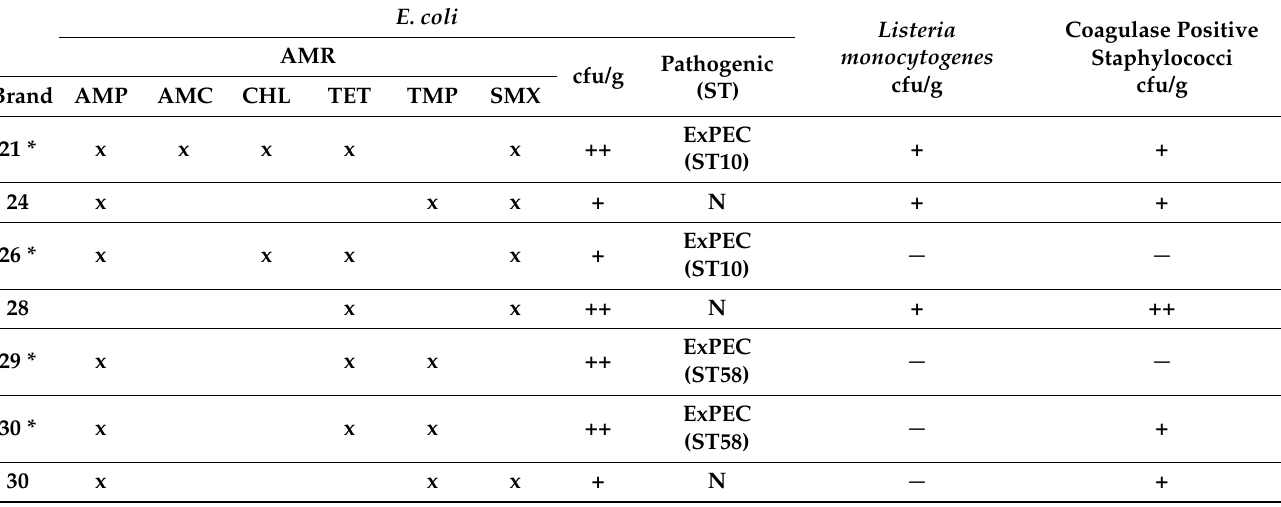
Table 4. Cont. E. coli